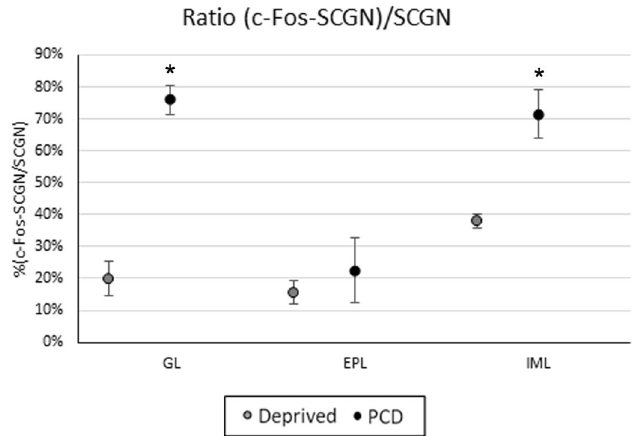
Figure 7. Quantification of c-Fos and SCGN colocalization in the OB of deprived (gray) and PCD (black) mice, expressed as doubly labeled cells in relation to the total SCGN-positive elements. As can be seen, there is a statistically significant increase of BrdU-SCGN co-expression in the glomerular layer (GL) and inframitral layers (IML) of PCD with respect to the deprived mice *p < 0.05, ** p <